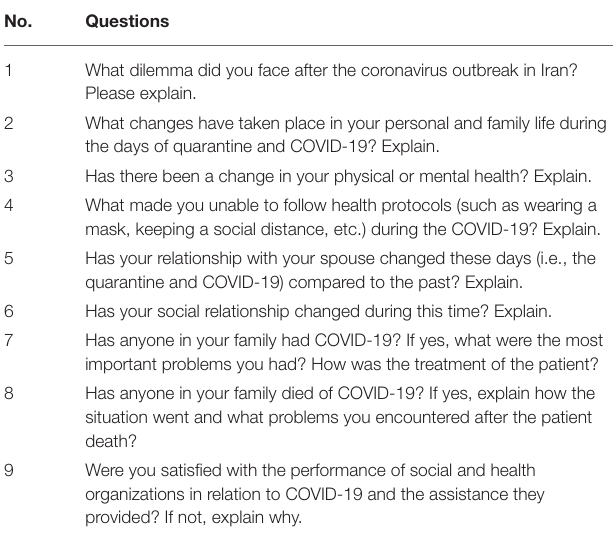
TABLE 1 | Checklist of interview guide